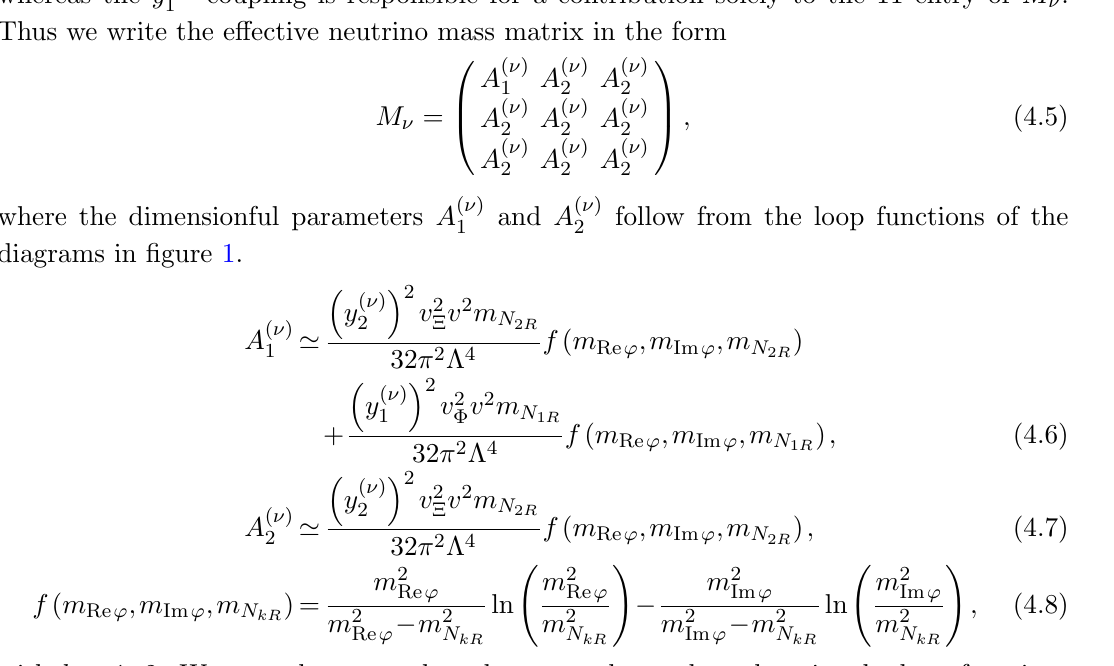
N nR ( n = 1 ; 2) denote the insertion (cid:0)